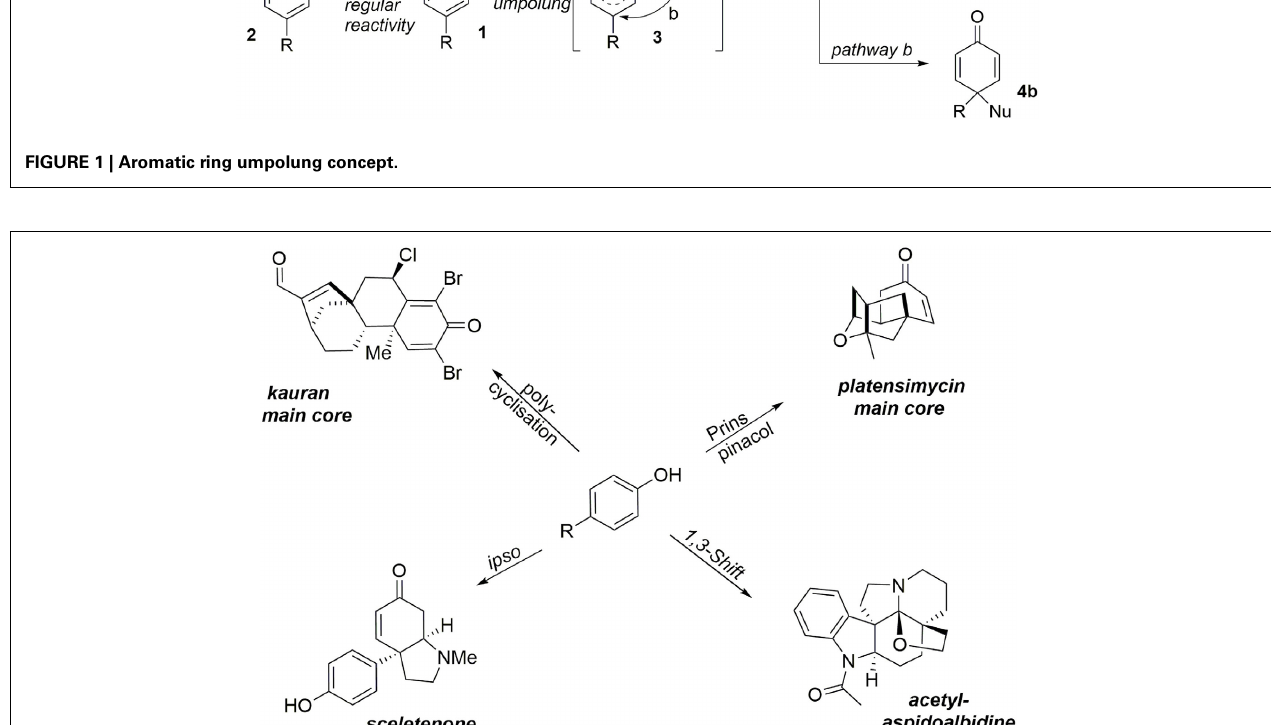
FIGURE 2 | Total syntheses of natural products bearing at least one quaternary carbon